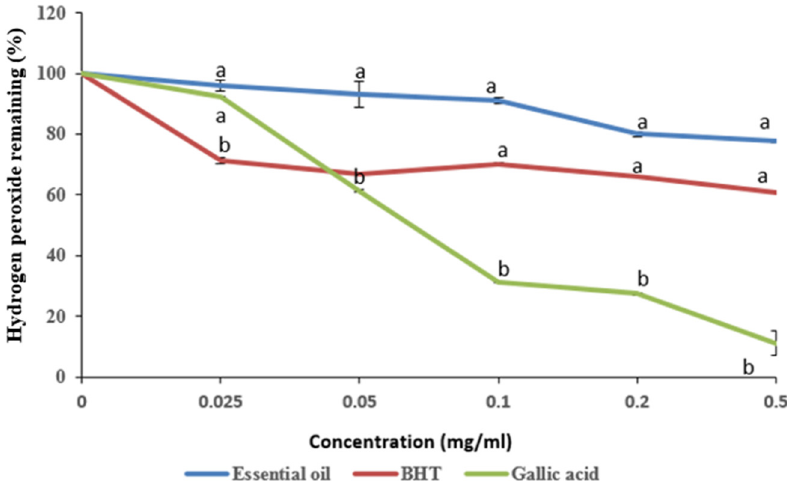
Figure 5. Hydrogen peroxide scavenging activity of the essential oil of H. africana. Lines with different letters within the same concentration are significantly different ( p <